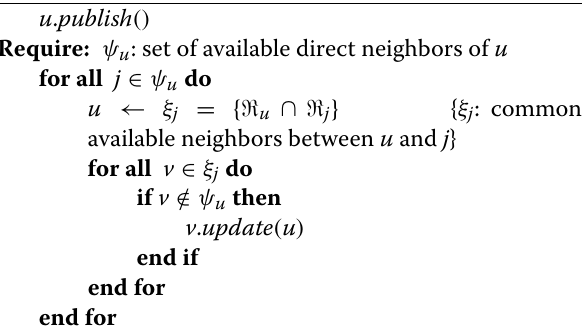
Algorithm 2 The publish procedure between nodes p